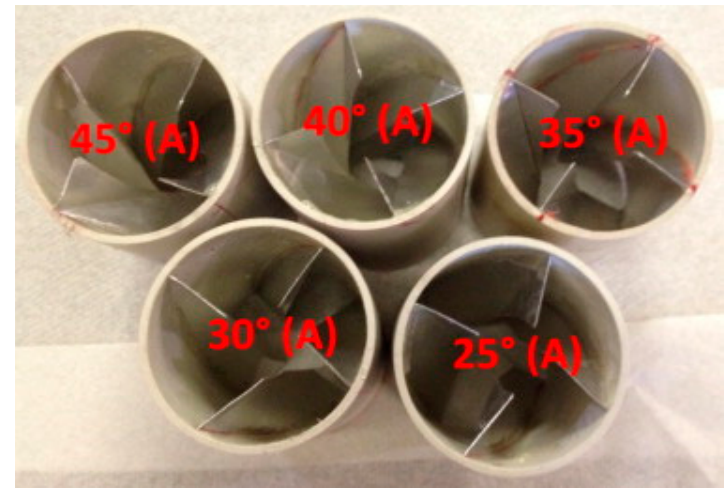
Figure 2. Images of the guide vanes.